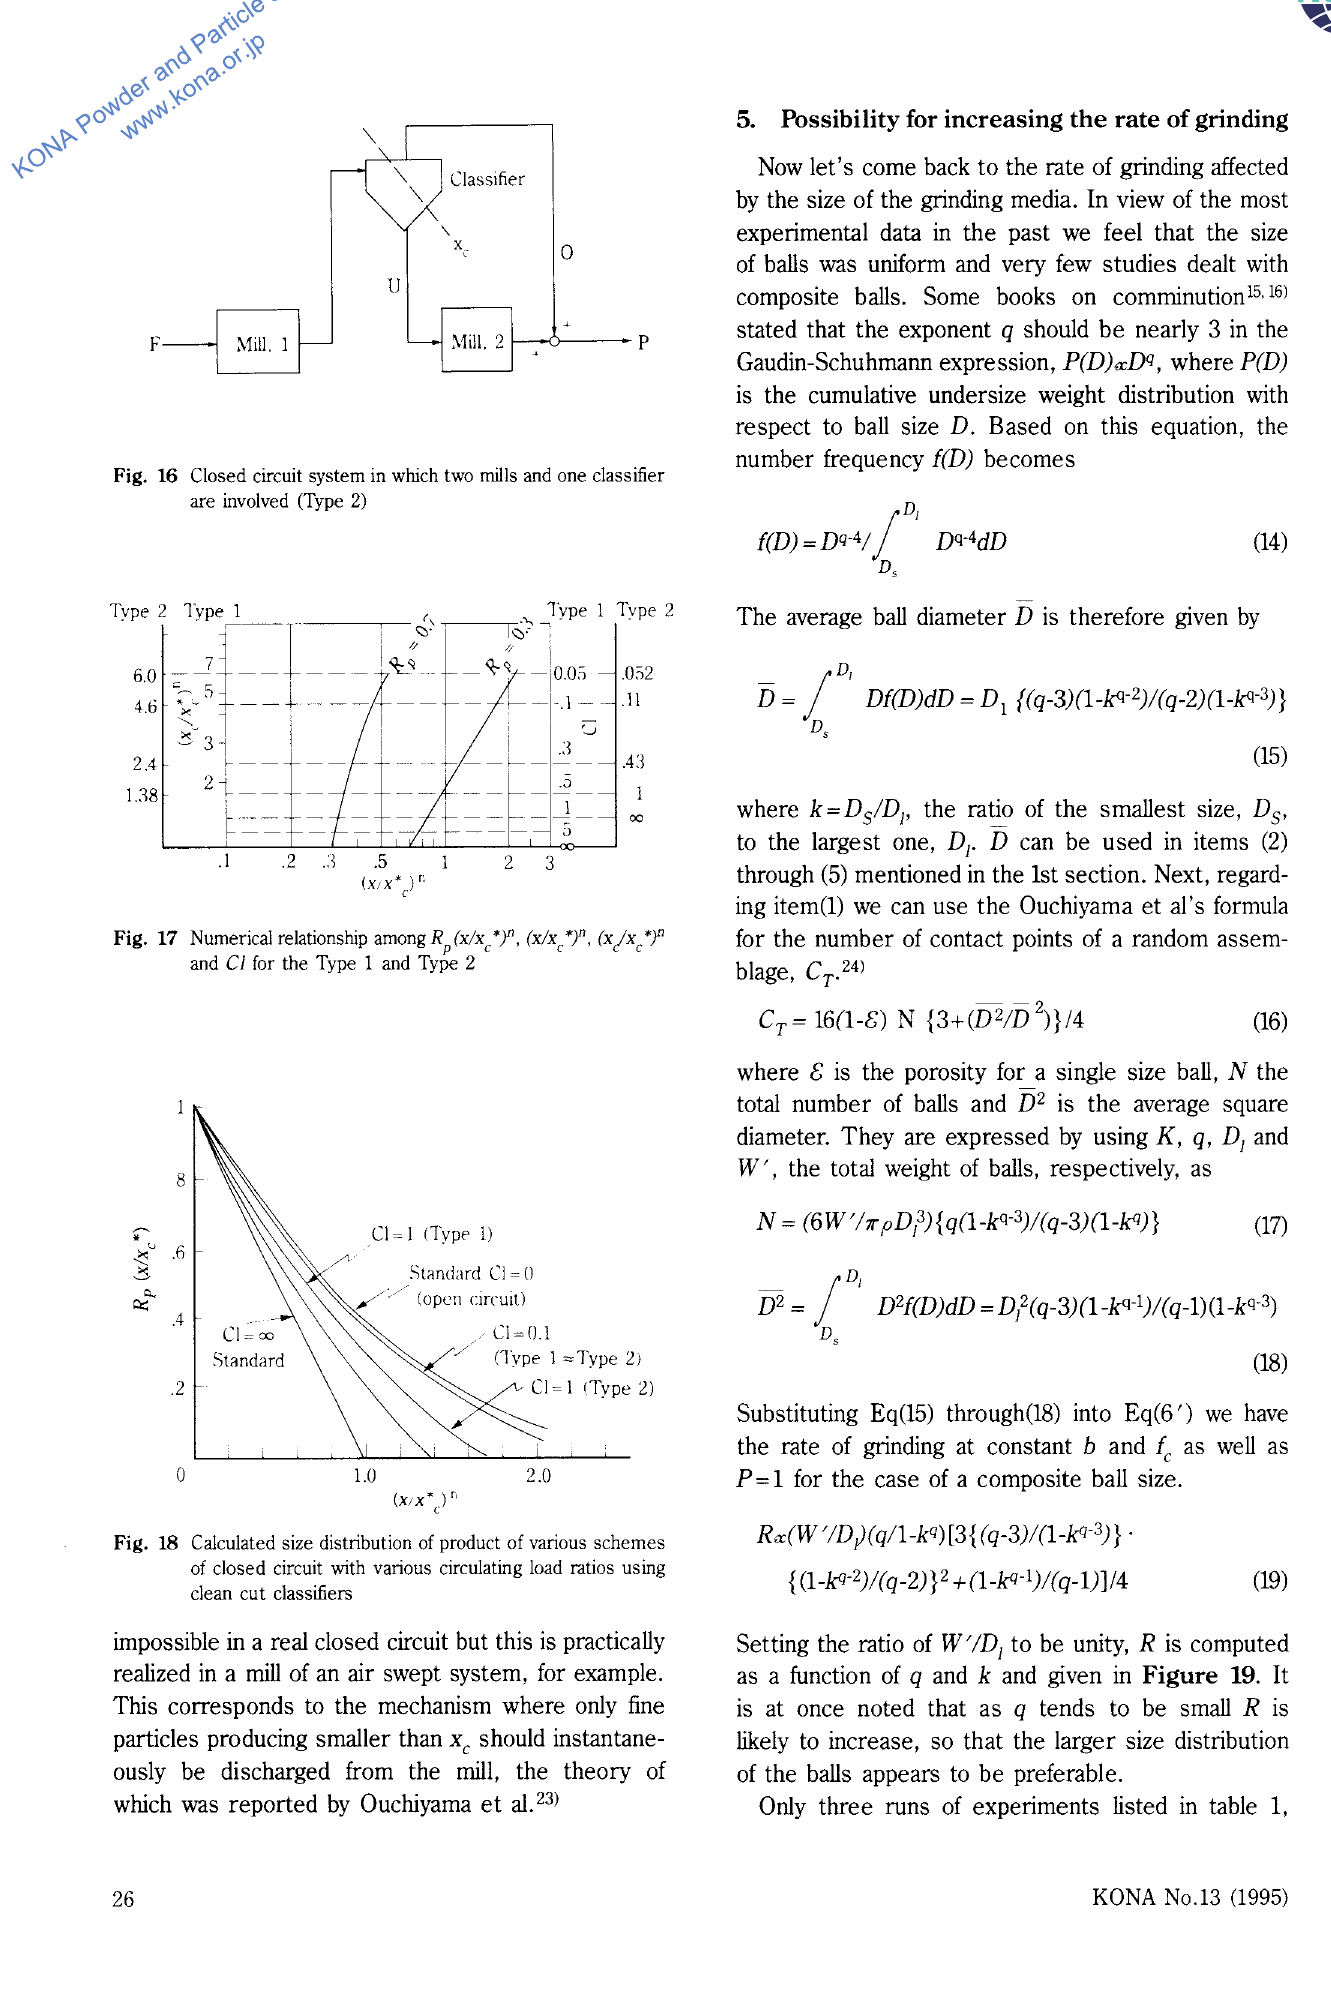
Fig. 18 Calculated size distribution of product of various schemes of closed circuit with various circulating load ratios using clean cut